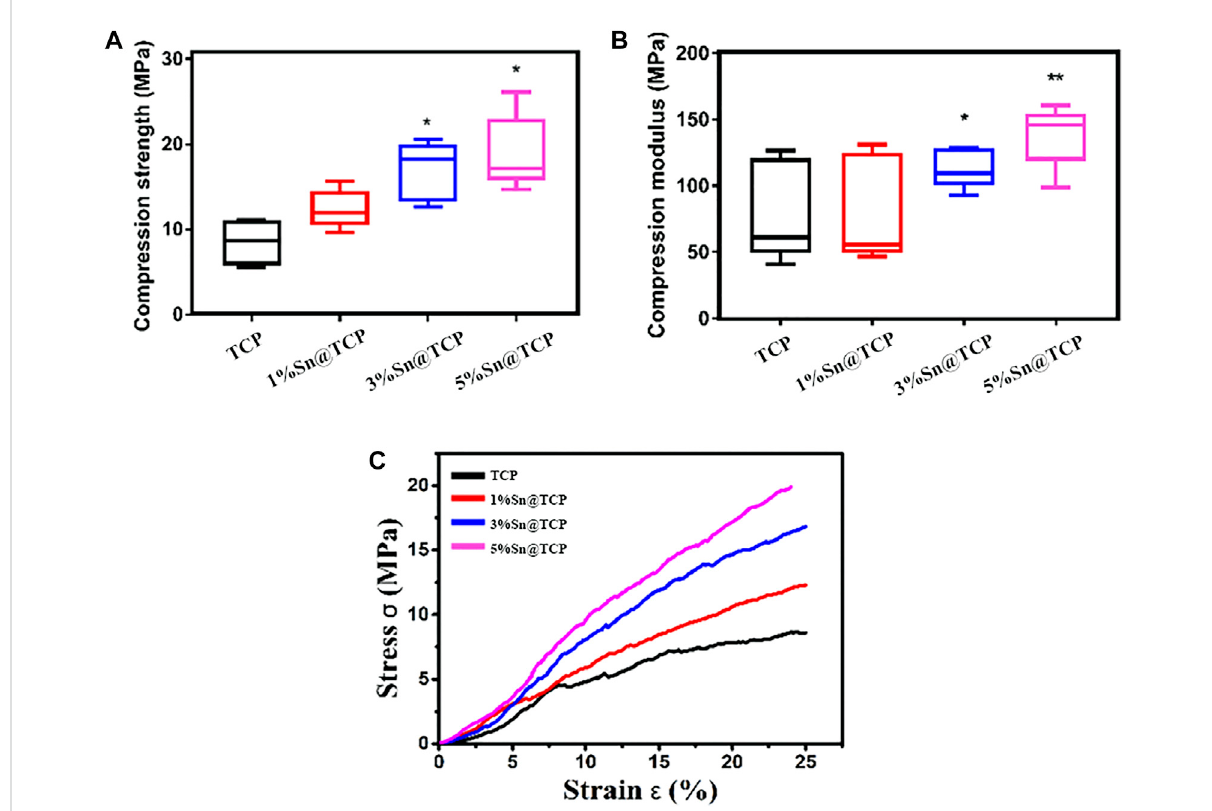
FIGURE 4 Mechanical Property of TCP scaffolds with different Sn doping. (A) The compression strength of TCP scaffolds with different Sn doping. (B) The compression modulus of TCP scaffolds with different Sn doping. (C) Strain-stress curve of TCP scaffolds with different Sn doping. Five scaffolds for each group (n = 5). Signi fi cance (* p < 0.05, ** p <